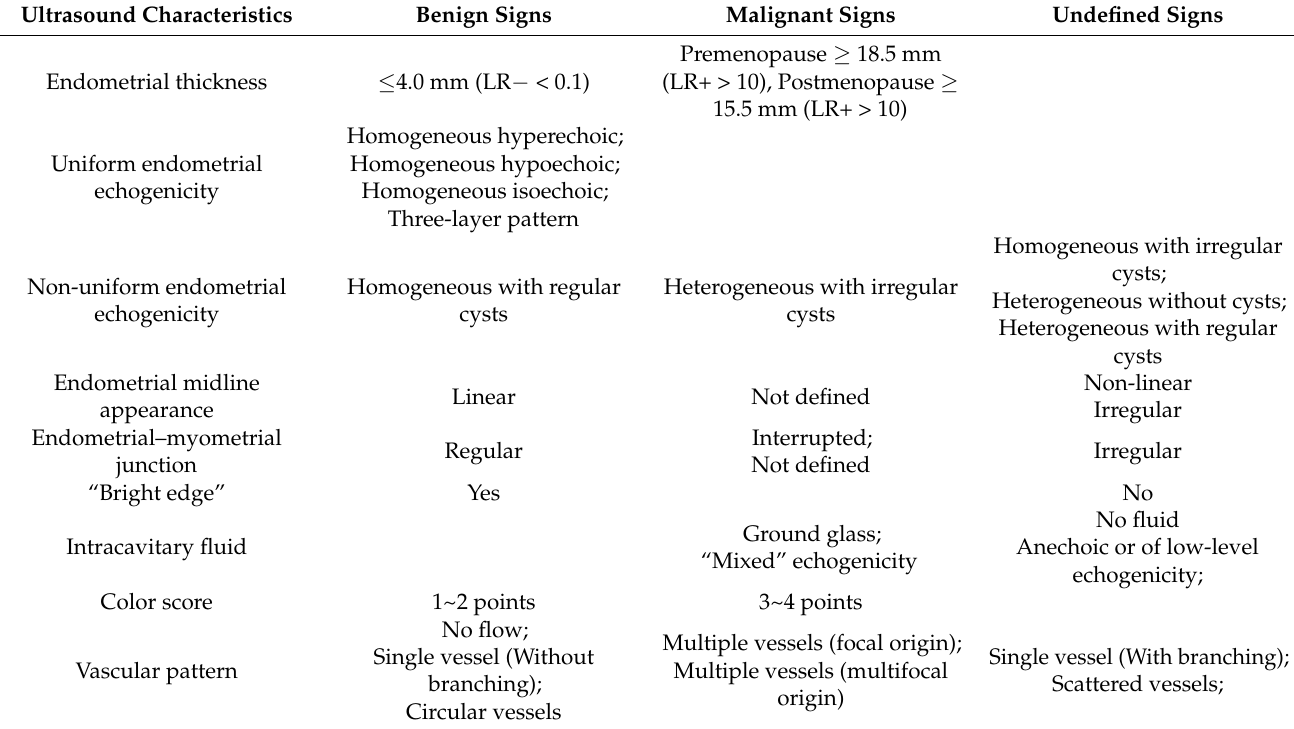
Table 3. The reference table for classification of benign and malignant IETA ultrasonographic features.